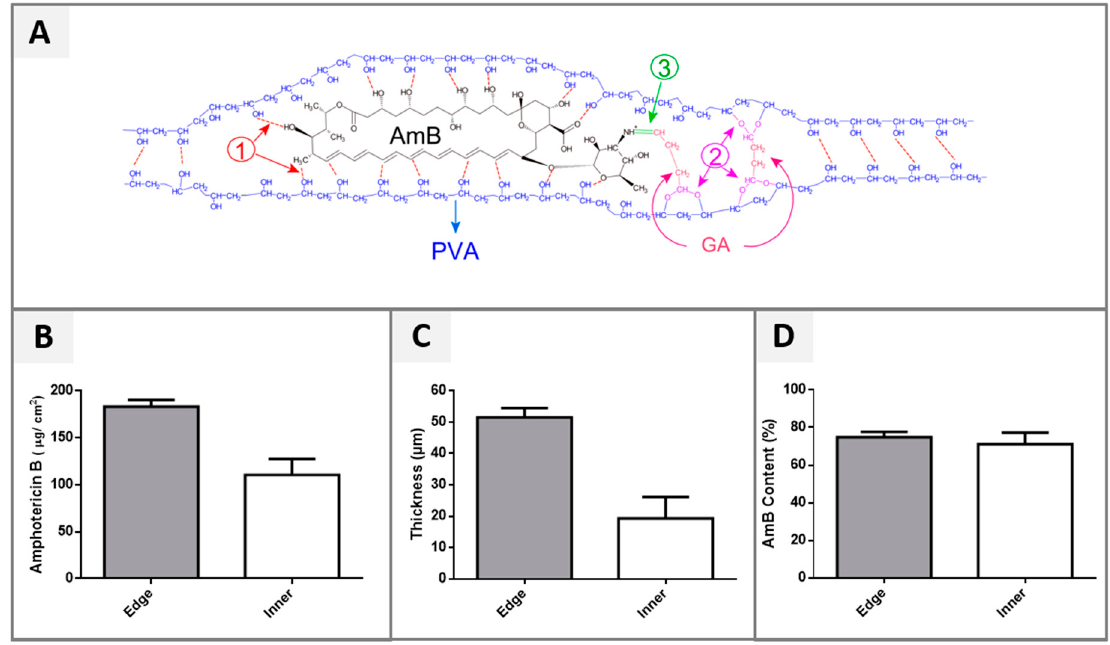
Figure 1. ( A ) Schematic representation of the hydrophilic interactions among the polymer chains, the cross-linker, and the Amphotericin B (AmB). (1) Hydrogen bound, (2) acetal formation and (3) imine formation improving the physical and chemical cross-linking [59]. ( B ) AmB content per unit area (1 cm 2 ), ( C ) thickness variation according to the hydrogel region ( D ) AmB values normalized according to the weight of fragments from each respective